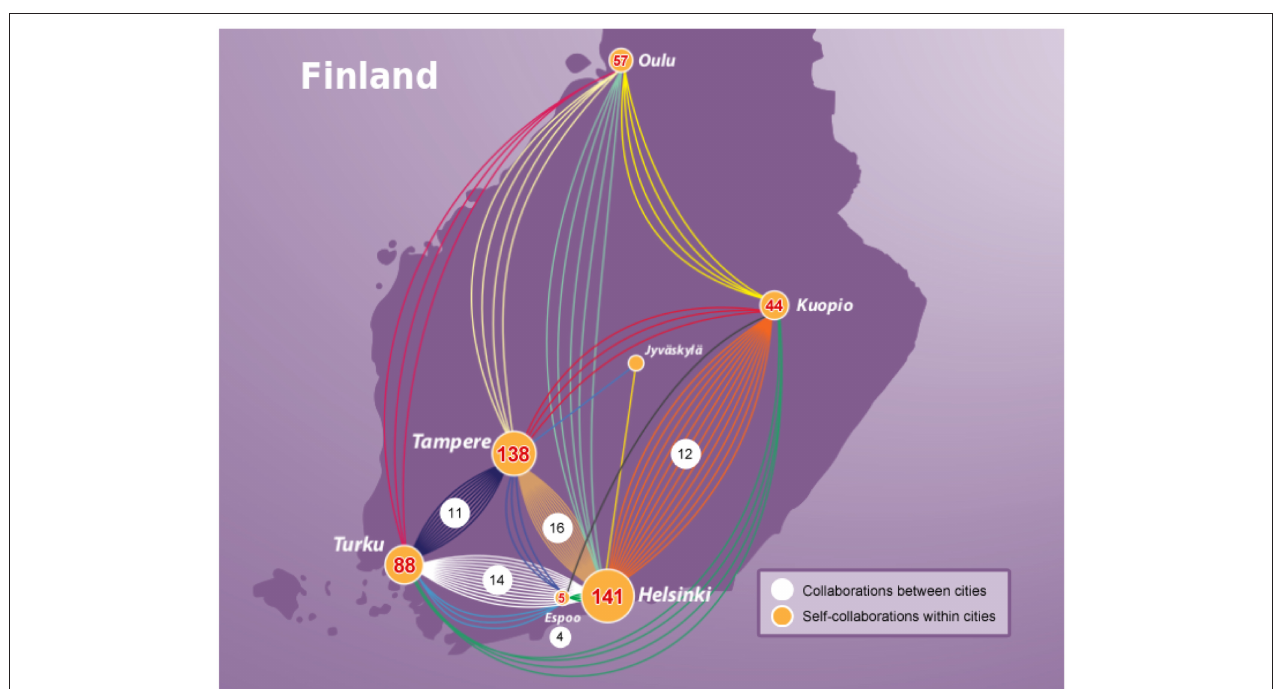
FIGURE 9 | Collaboration network of Finland for genetics research in prostate cancer. Nodes correspond to cities and edges correspond to jointly published articles. The numbers provide information about the number of collaborations between cities (white background) and self-collaborations within cities (yellow background).